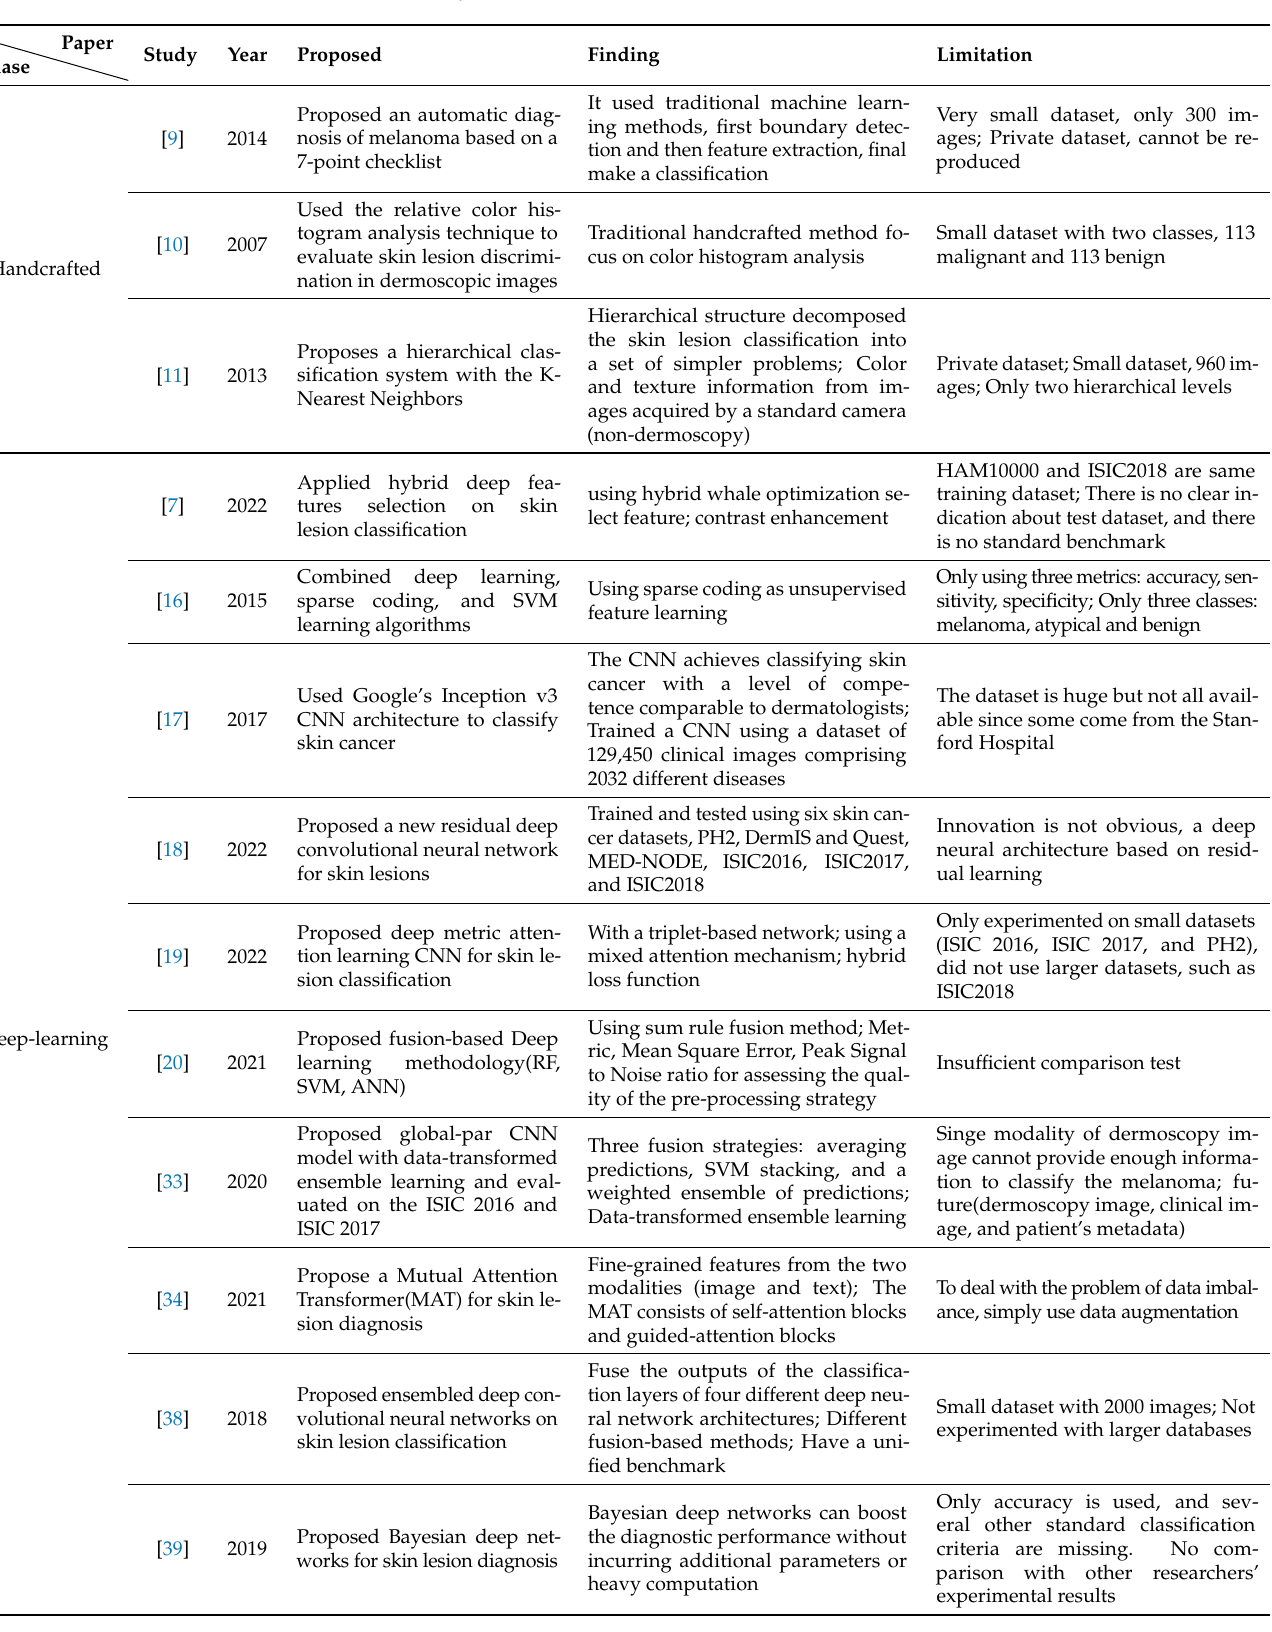
Table 1. Summary of the selected related